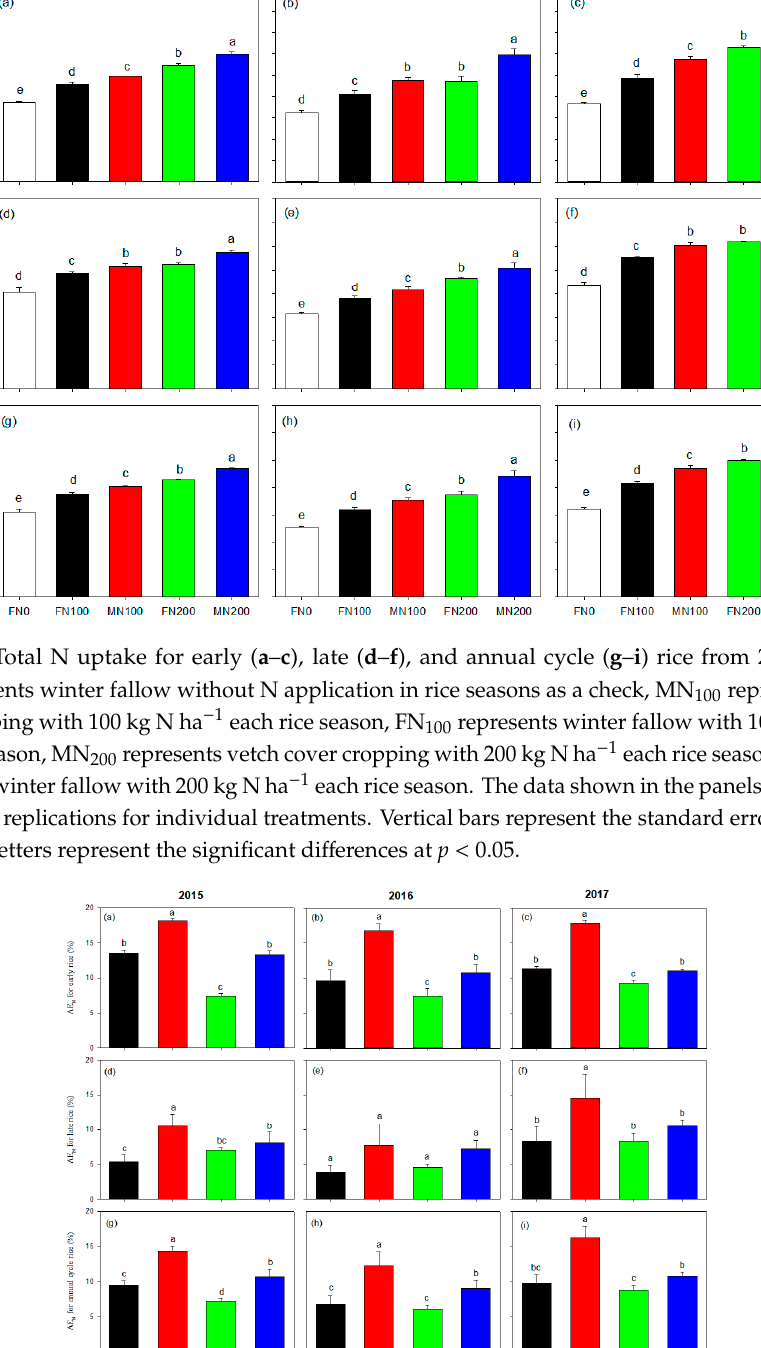
Figure 3. Agronomic N use e ffi ciency for early ( a – c ), late ( d – f ), and annual cycle ( g – i ) rice from 2015 to 2017. FN 0 represents winter fallow without N application in rice seasons as a check, MN 100 represents vetch cover cropping with 100 kg N ha − 1 each rice season, FN 100 represents winter fallow with 100 kg N ha − 1 each rice season, MN 200 represents vetch cover cropping with 200 kg N ha − 1 each rice season, and FN 200 represents winter fallow with 200 kg N ha − 1 each rice season. The data shown in the panels are averages of the three replications for individual treatments. Vertical bars represent the standard errors. Di ff erent lowercase letters represent the significant di ff erences at p < 0.05.